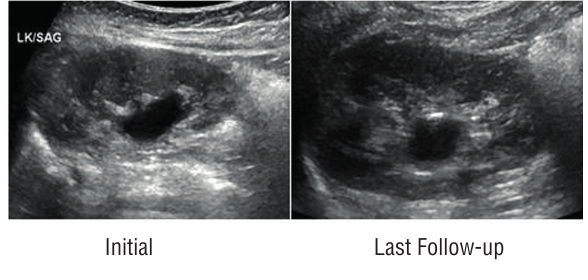
figure 1 - Renal US image in a patient with initial grade-1 HN and last follow-up US showing persistent grade-1 HN.